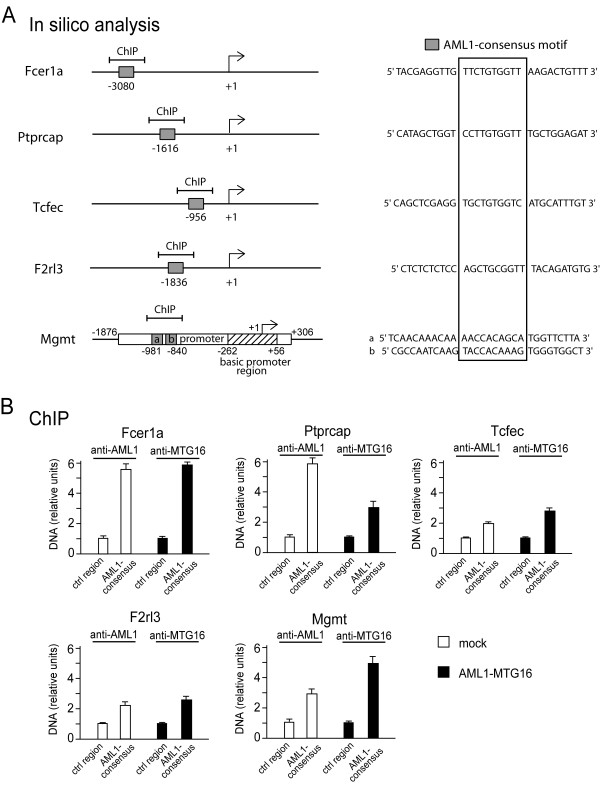
AML1-target gene validation. A. Relative position of the AML1-consensus motifs (left) and their sequence (right) in the five putative AML1-target genes that were analyzed by ChIP. B. Quantitative ChIP analysis with antibodies either against AML1 or MTG16 showing a significant (p < 0.05) enrichment of chromatin containing AML1-consensus motifs vs. chromatin containing a control region in AML1-MTG16-negative and AML1-MTG16-positive cells, respectively.